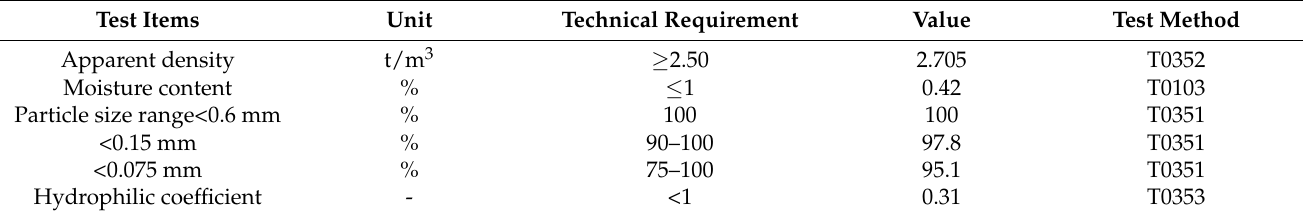
Table 3. Main properties of limestone mineral